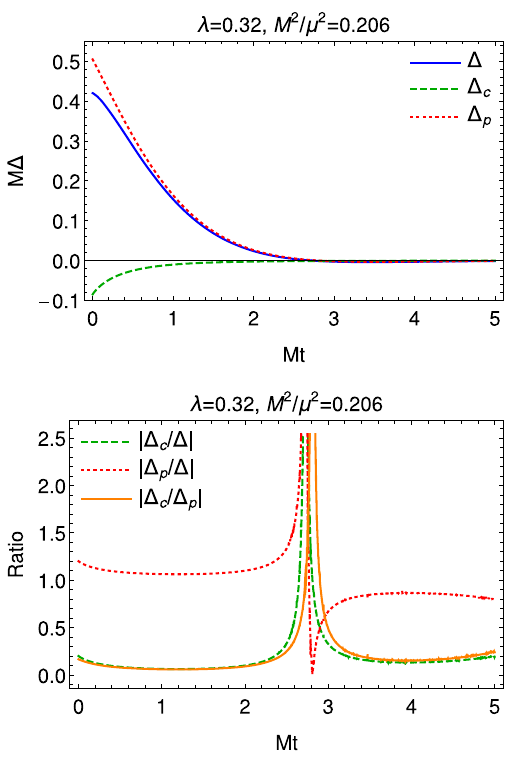
Fig. 19 The comparison of the pole and cut parts with the original gluon Schwinger function in the Euclidean region (cid:6)( t ) = (cid:6) p ( t ) + (cid:6) ( t ) for k 2 < 0: (top) the pole part (cid:6) ( t ) (red dotted line) and the cut c p part (cid:6) c ( t ) (green broken line) in the gluon Schwinger function (cid:6)( t ) (bluesolidline),(bottom)theabsolutevaluesoftheratios (cid:6) c , p ( t )/(cid:6)( t ) of the pole (cid:6) p ( t ) and cut (cid:6) c ( t ) parts to the total gluon Schwinger function, | (cid:6) p ( t )/(cid:6)( t ) | (red dotted line), | (cid:6) c ( t )/(cid:6)( t ) | (green broken line), and | (cid:6) c ( t )/(cid:6) p ( t ) | (orange solid line), at the physical point of the parameters λ := Ng 2 /( 4 π) 2 = 0 . 32, M 2 /μ 2 = 0 . 206. Notice that